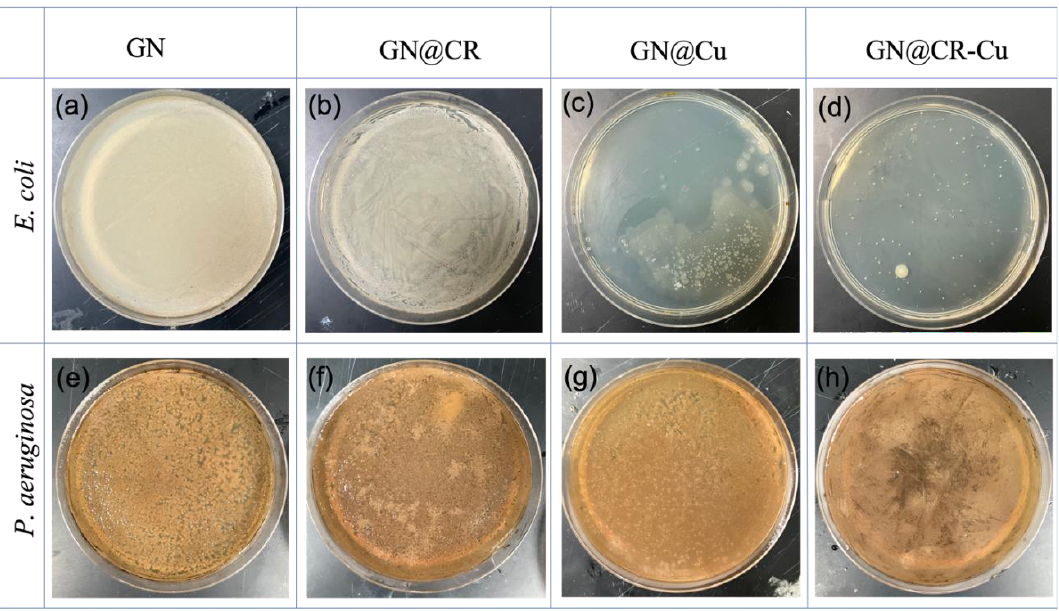
Figure 7. Test bacteria E. coli ( a – d ), P. aeruginosa ( e – h ): The minimum inhibition by the nanocomposite material on the bacteria cultivated Petri plates.